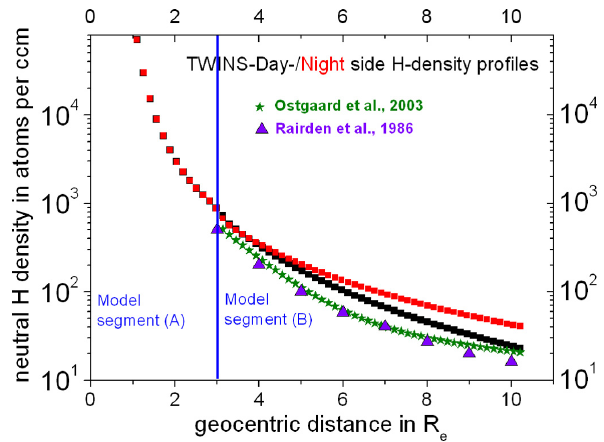
Fig. 4. Dayside ( φ = 0 ◦ , black)/nightside ( φ = 180 ◦ , red) profiles of the TWINS H-density model in comparison with the yearly average φ = 90 ◦ H-density profiles from Østgaard et al. (2003) (green stars) and from Rairden et al. (1986) (violet triangles).